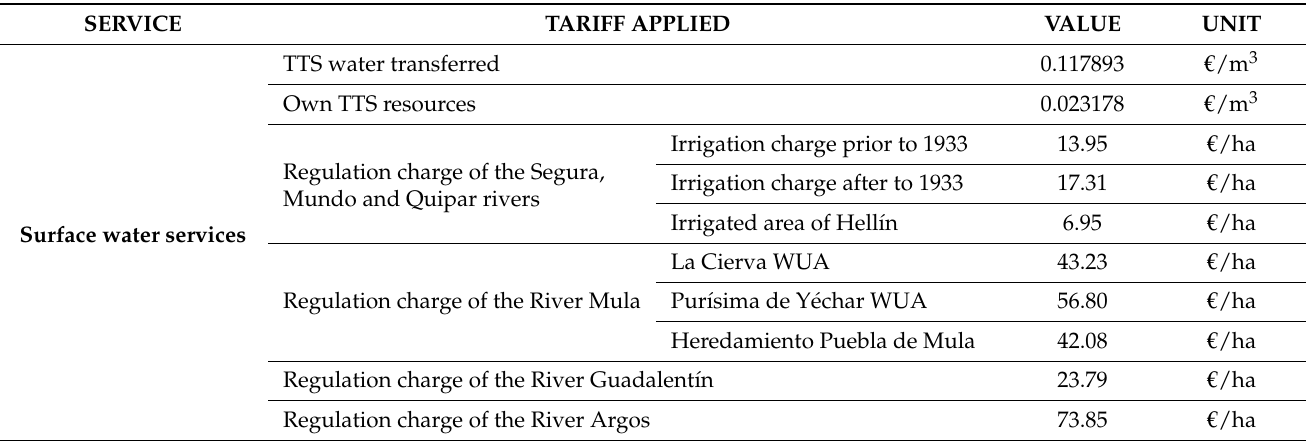
Table 16. Tariffs and charges used in the cost recovery analysis for use in irrigation. Source: own elaboration based on